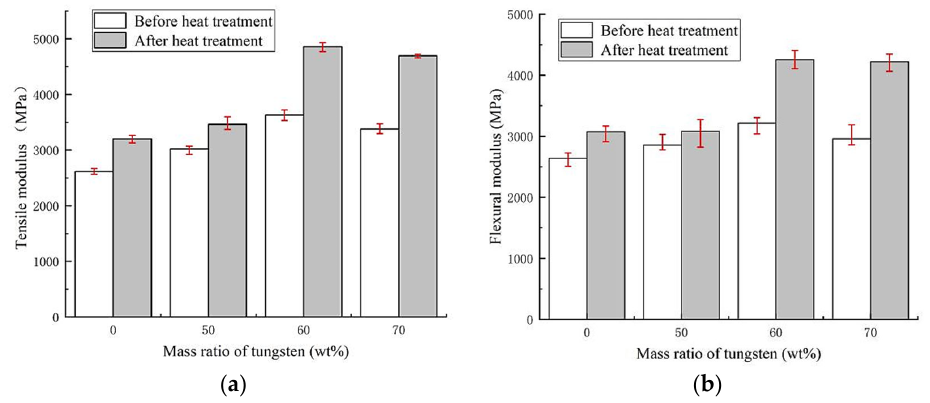
Figure 14. Tensile modulus and Flexural modulus of PEEK and PEEK/tungsten composites: ( a ) tensile modulus and ( b ) flexural modulus.